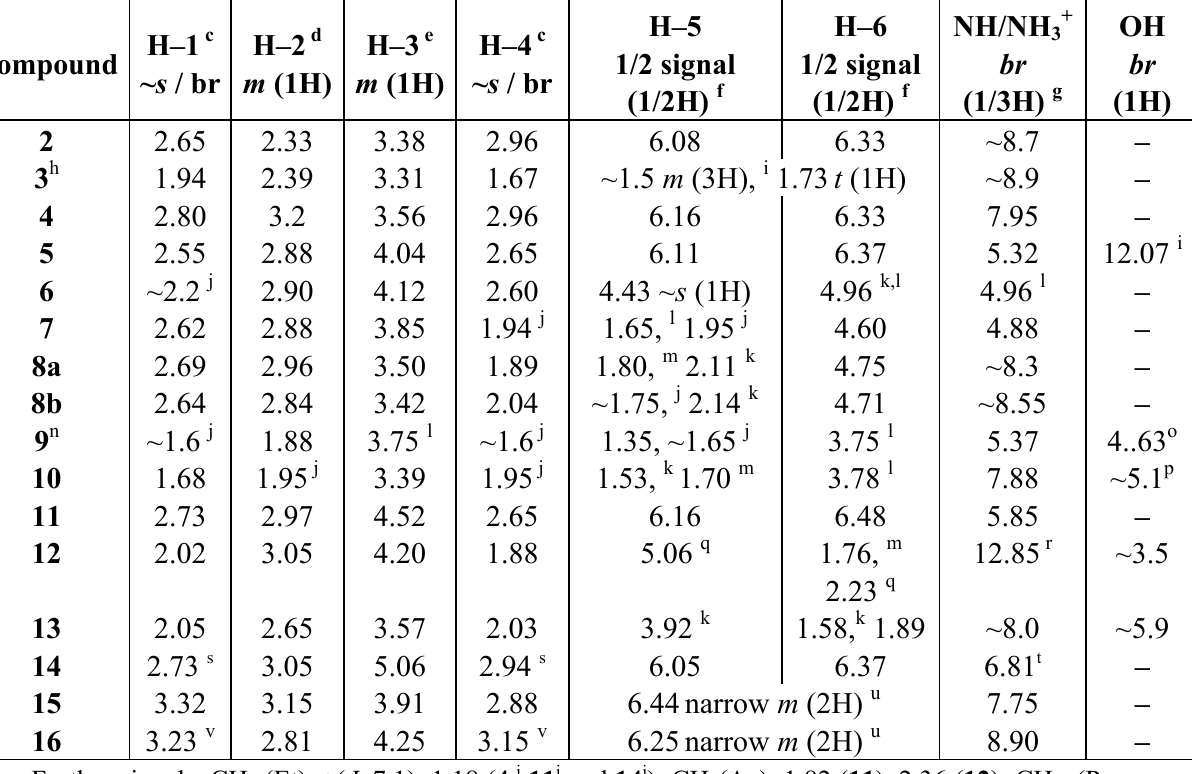
Table 1. 1 H NMR chemical shifts a of compounds 2–7 , 8a , b and 9–16 b